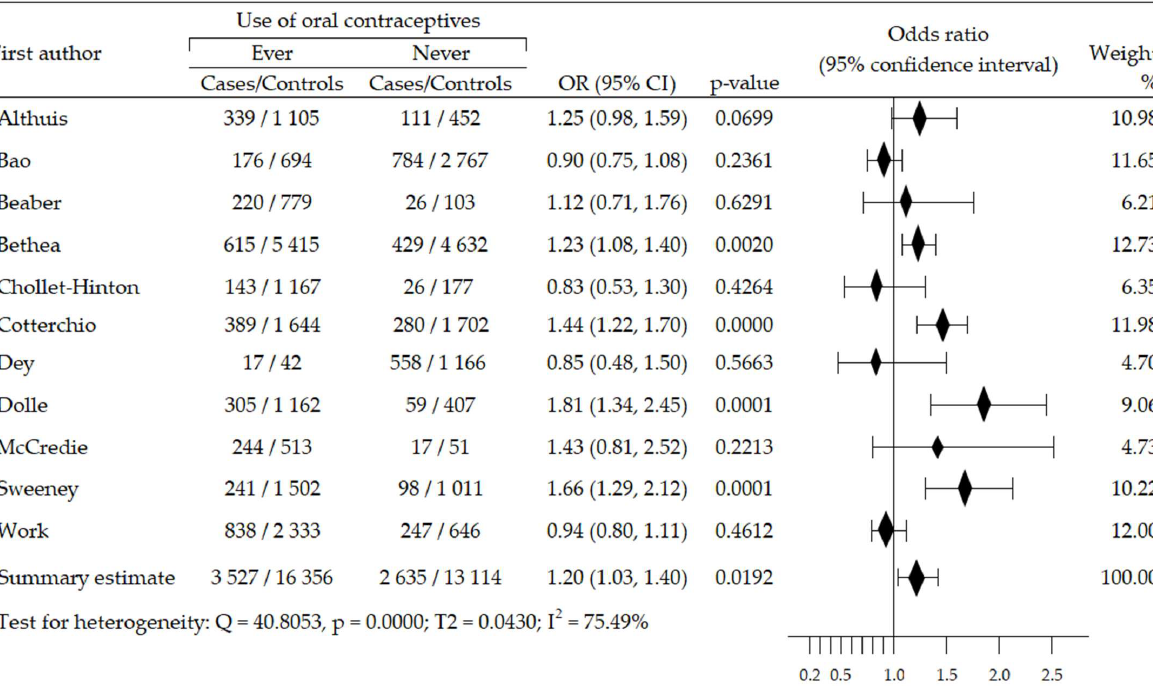
Figure 3. Forest plot and summary odds ratios on the association between risk of ER−BrCa and ever-use of oral contraceptives. Note: black diamonds represent the effect sizes; the horizontal lines denote the 95% confidence interval.